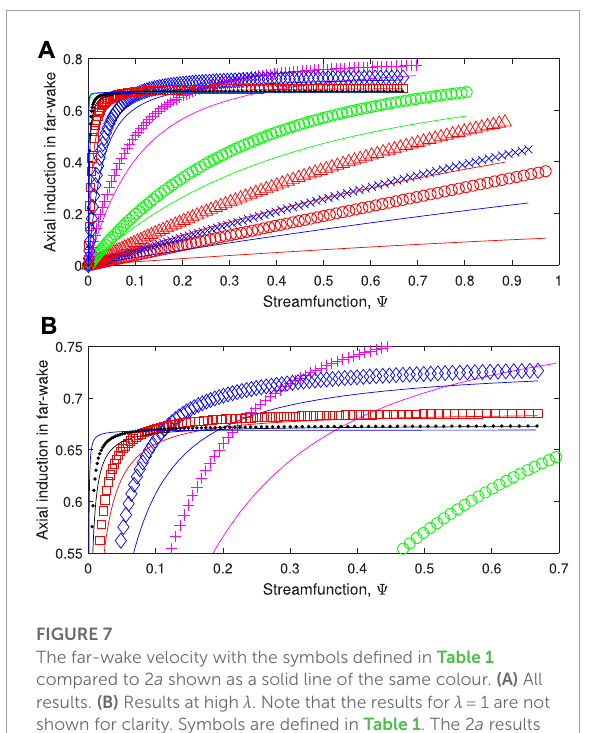
FIGURE 7 The far-wake velocity with the symbols defined in Table 1 compared to 2 a shown as a solid line of the same colour. (A) All results. (B) Results at high λ . Note that the results for λ = 1 are not shown for clarity. Symbols are defined in Table 1 . The 2 a results for λ = 50 cannot be distinguished from the lines showing a ∞ .